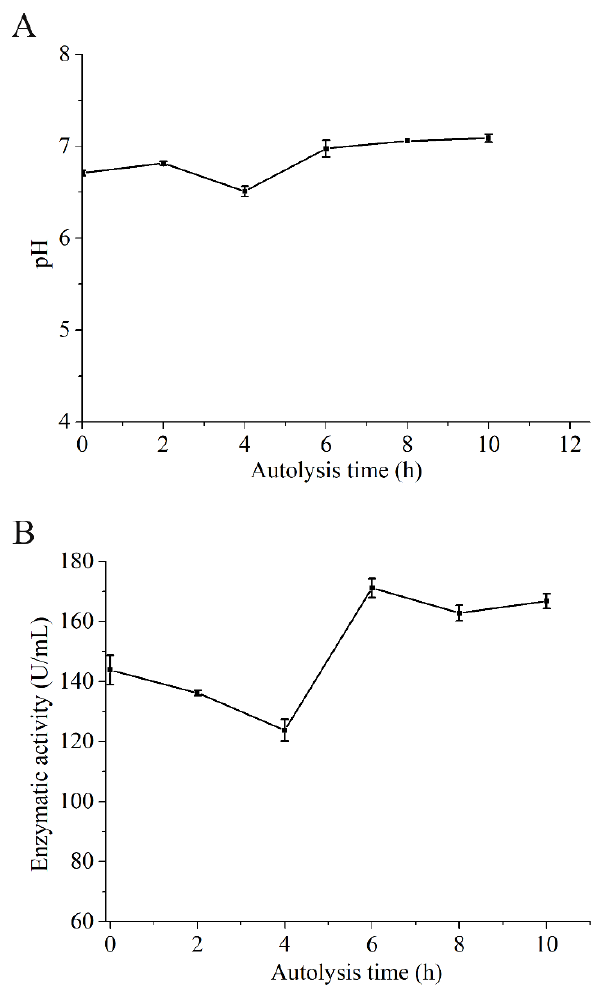
Figure 5. The changes of ( A ) pH and ( B ) enzymatic activity in shrimp during